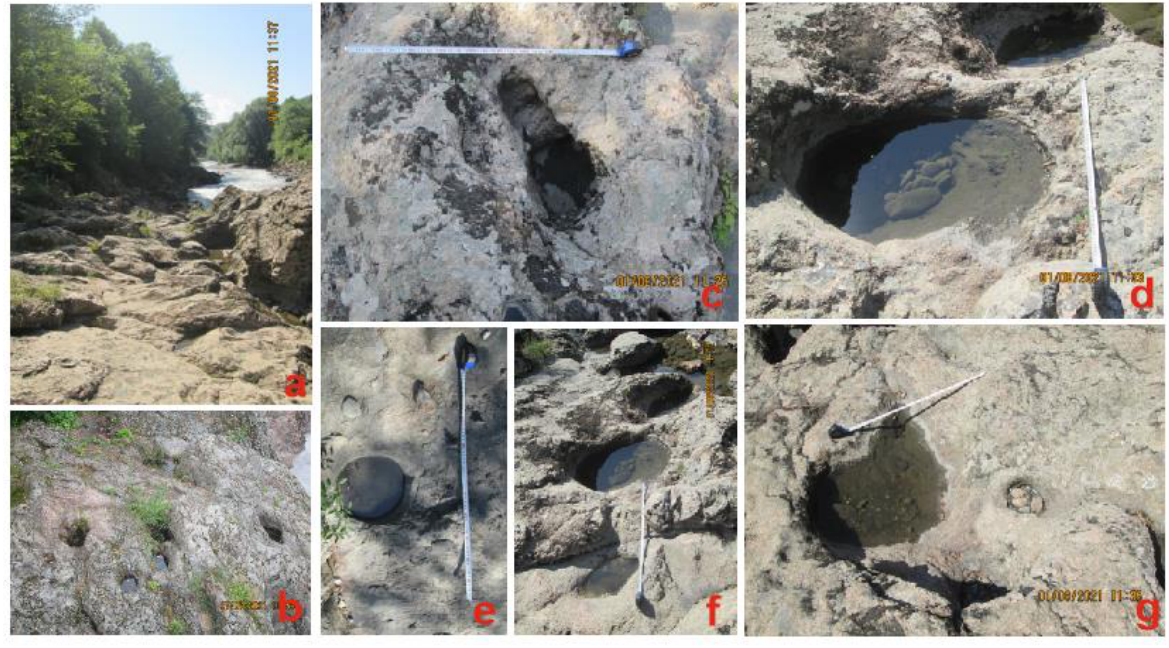
Figure 2. The relatively small granite pseudokarst features from the study plot and its vicinity: ( a ) general view of the plot (the size of ~100 m 2 ) with visible rock basins, channels, and large clasts, ( b , c ) hollows, ( d – f ) shallow rock basins, ( g ) shallow rock basin with complex morphology (the tape indicates 1 m on ( c – g ), the size of the features is ~30 cm on ( b )).